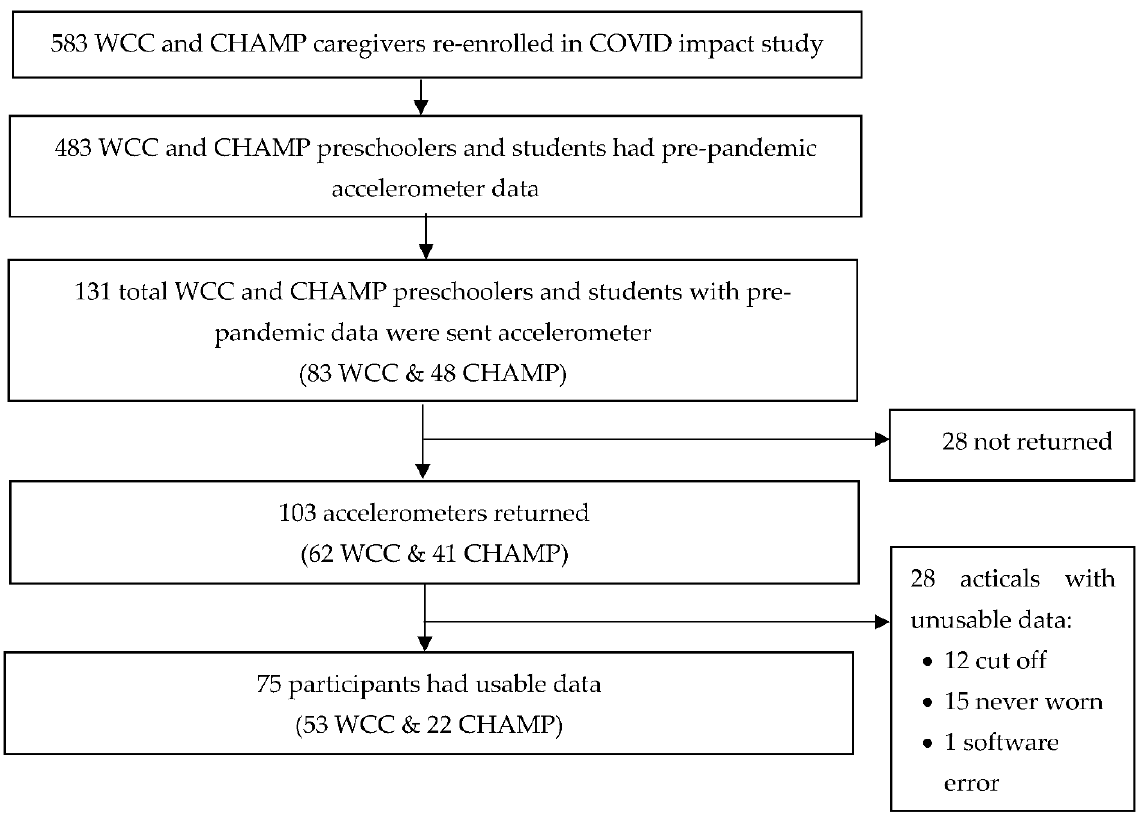
Figure 1. Participant flow chart.